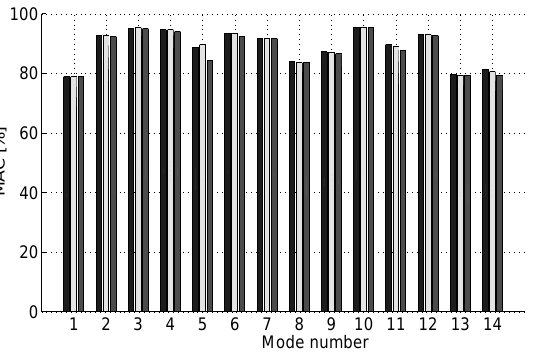
Fig. 14. Mode correlation after modification 2 of the updated model: R&A dark gray, R&AV light gray, R&MAC medium gray. on mode shape amplitudes of all modes at a single DoF, whilst MAC is affected by mode shape amplitudes of